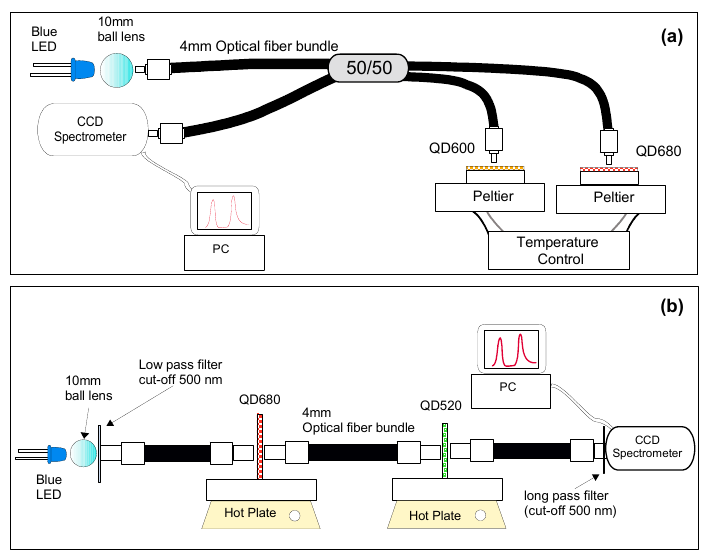
Figure 8. Reflection (a) and transmission (b) configurations used to interrogate simultaneously two different samples of sol-gel glass doped with semiconductor